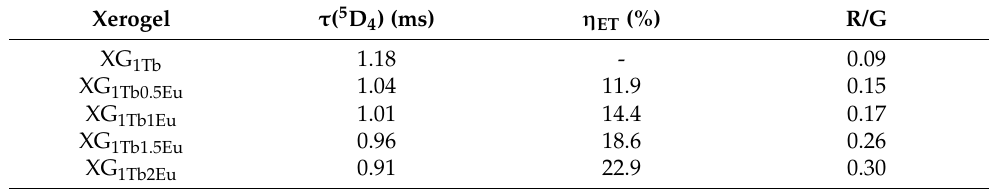
Figure 12. Luminescence decay curves of the 5 D 4 (Tb 3+ ) level recorded for individual XG 1TbxEu and GC 1TbxEu co-doped samples: ( a ) Xerogels, ( b ) glass-ceramics. The curves were recorded upon excitation at λ exc = 351 nm. Table 1. Measured lifetimes of the 5 D 4 state (Tb 3+ ), energy transfer efficiencies, and R/G ratio values for prepared